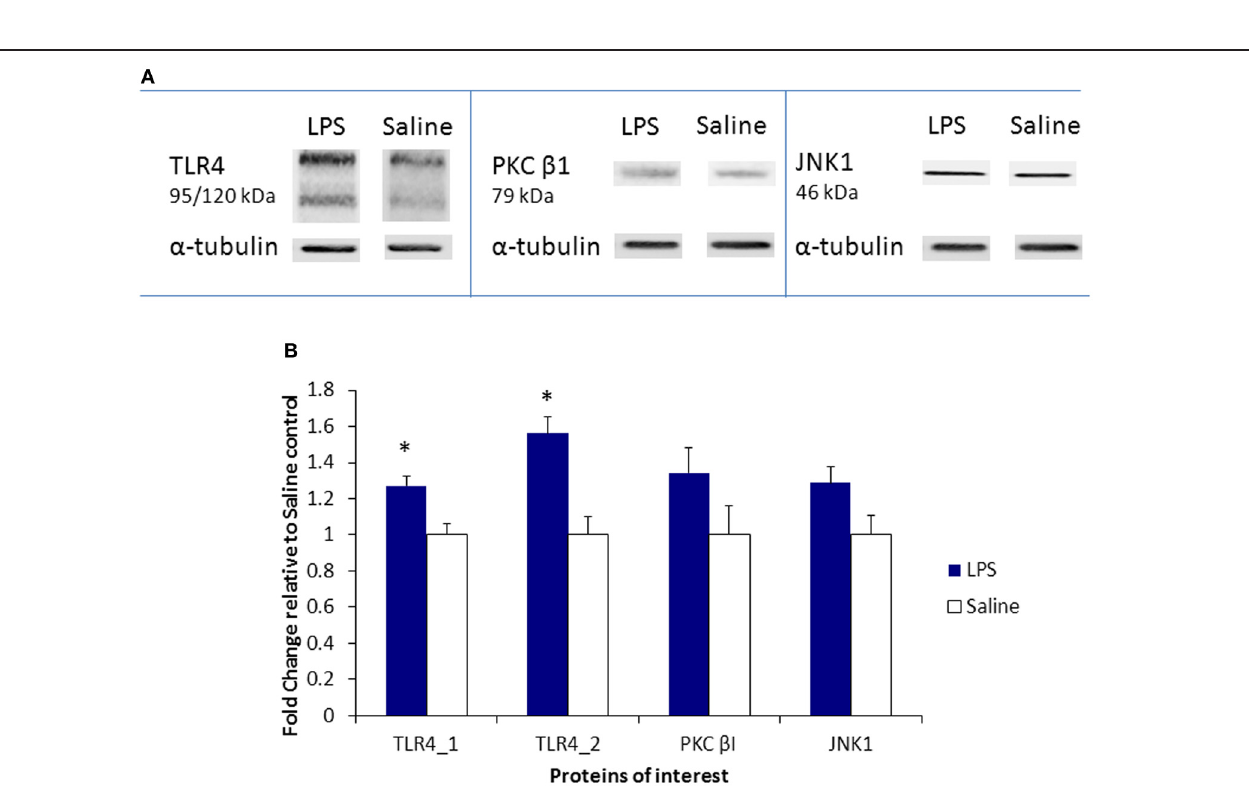
FIGURE 3 | Protein expression of TLR4, PKC β , and JNK1 in the neonatal ovary. (A) Changes in protein expression, as identified by immunoblotting analysis, are presented as a fold change relative to the saline control. (B)